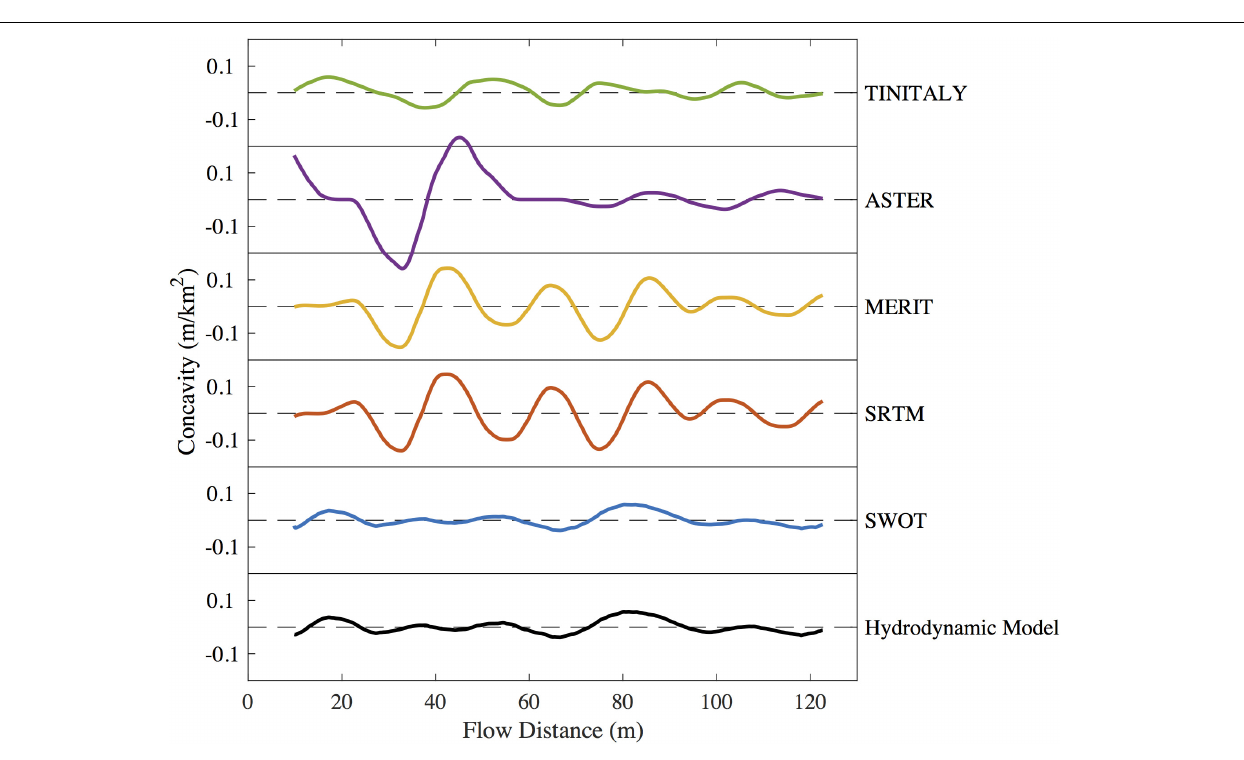
FIGURE 9 | Calculated concavity for all water surface profiles of the Po